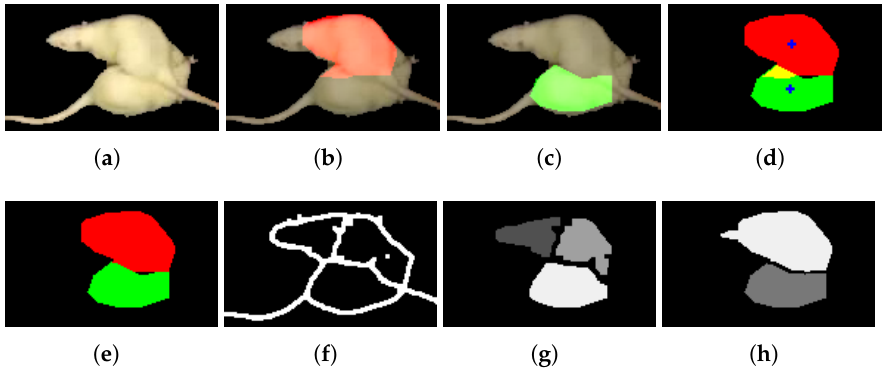
region is assigned to all edge regions, then body information is ignored, and initial labeling is created using only in the edge